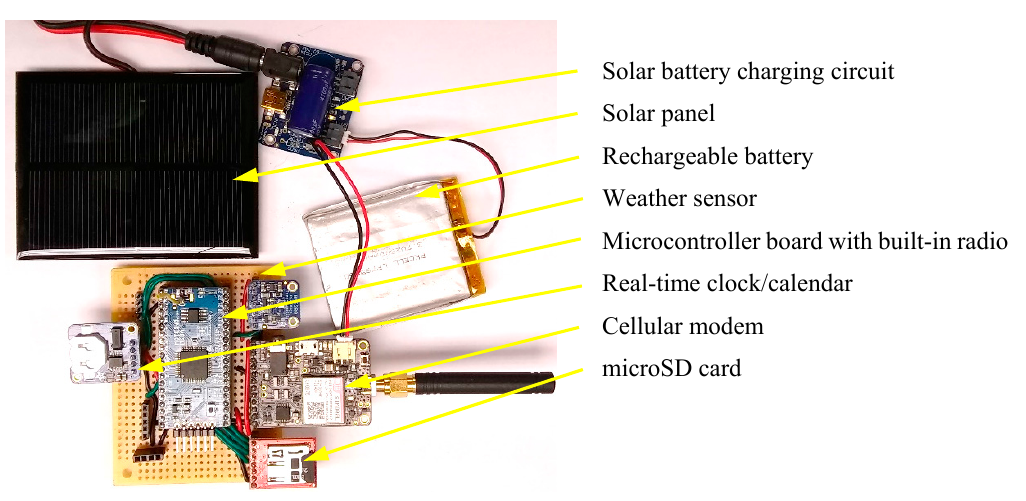
Figure 4. Cellular gateway electrical schematic.